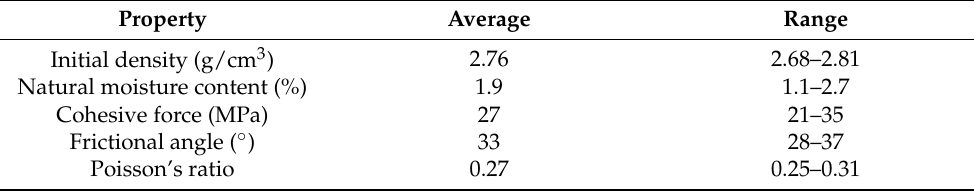
Table 2. Basic physical and mechanical properties of